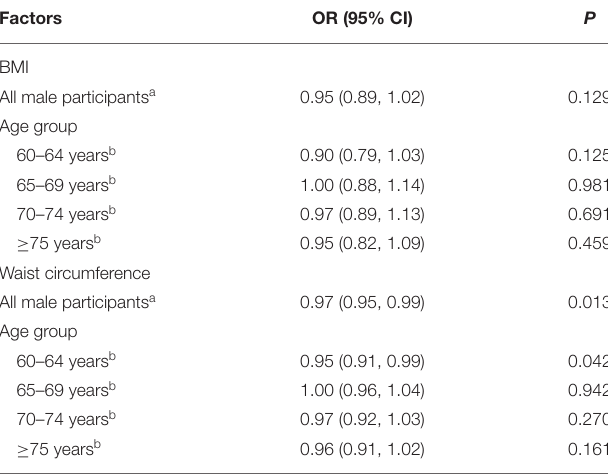
TABLE 3 | Association of BMI and waist circumference with cognitive impairment by age groups among elderly men in the multivariate analysis.